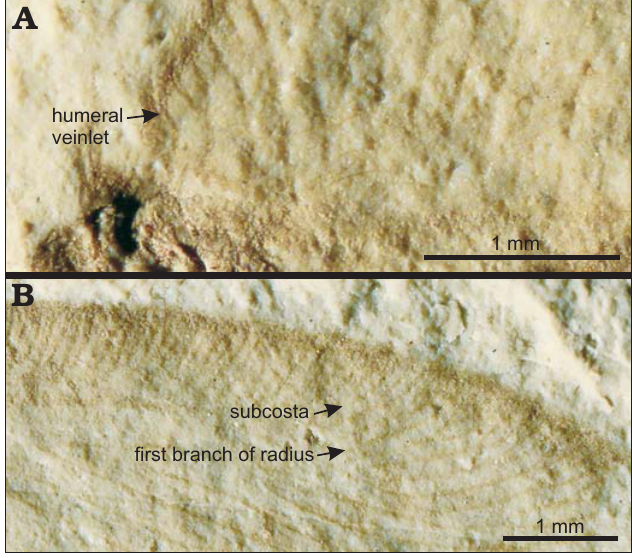
Fig. 3. Moth lacewing Guithone bethouxi gen. et sp. nov. holotype (CNU- NEU-NN2015003P/C) from Bathonian–Callovian boundary (Middle Ju- rassic) of Jiulongshan Formation of Daohugou, China. Dry photographs of details of the left forewing venation: proximal part of costal area ( A ), distal of subcosta and first branch of radius ( B ).